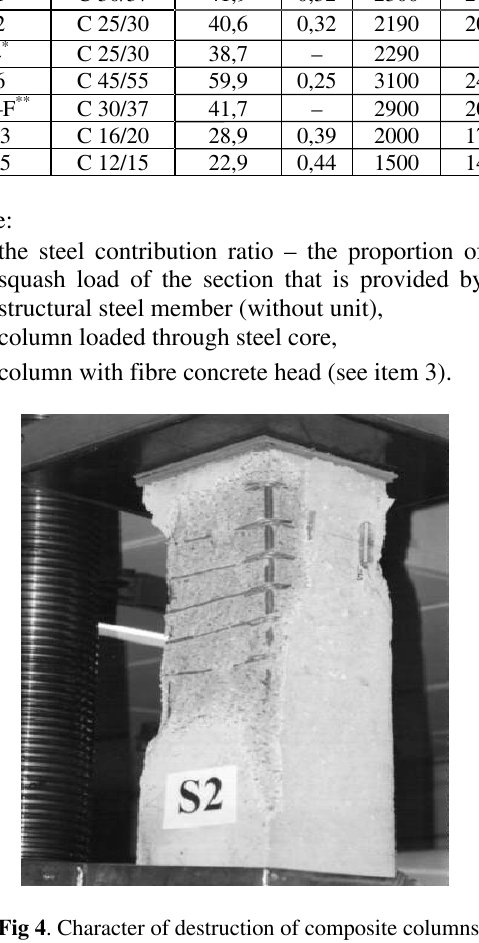
Fig 4 . Character of destruction of composite columns loaded over the composite cross-section